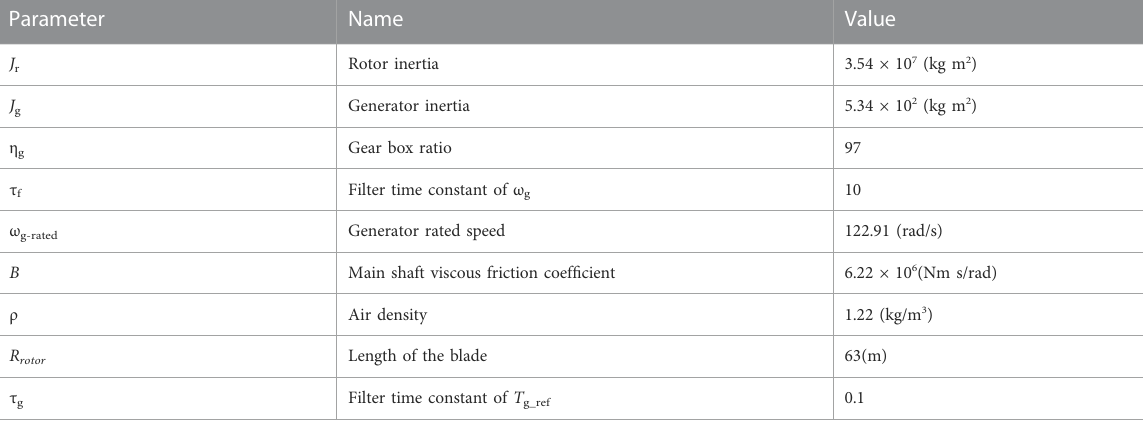
TABLE 2 Main parameters of the wind